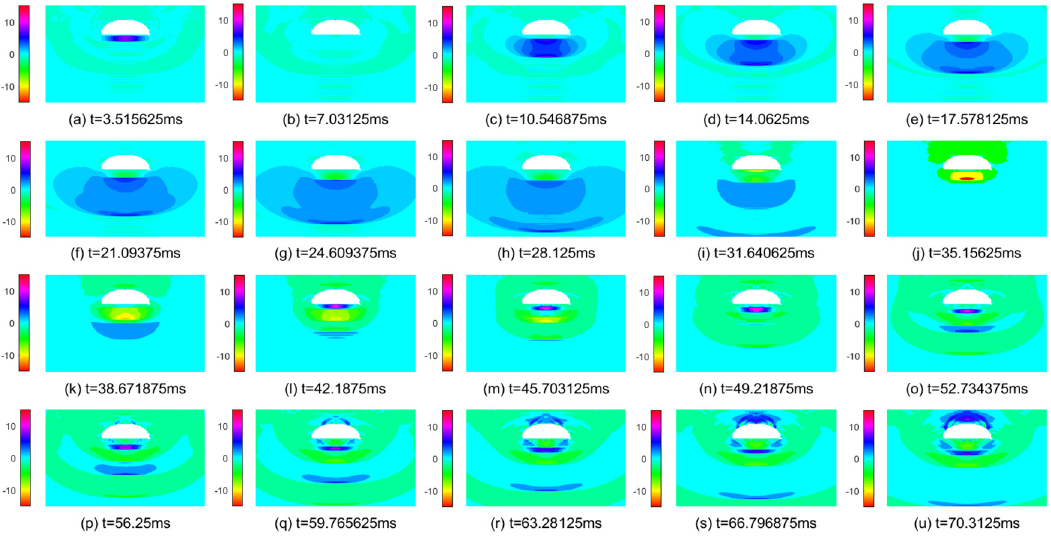
Figure 13. Distribution of p with of domain ( x 1 , x 3 ) ∈ [ − 10, 10 ] × [ − 20, 0 ] at different